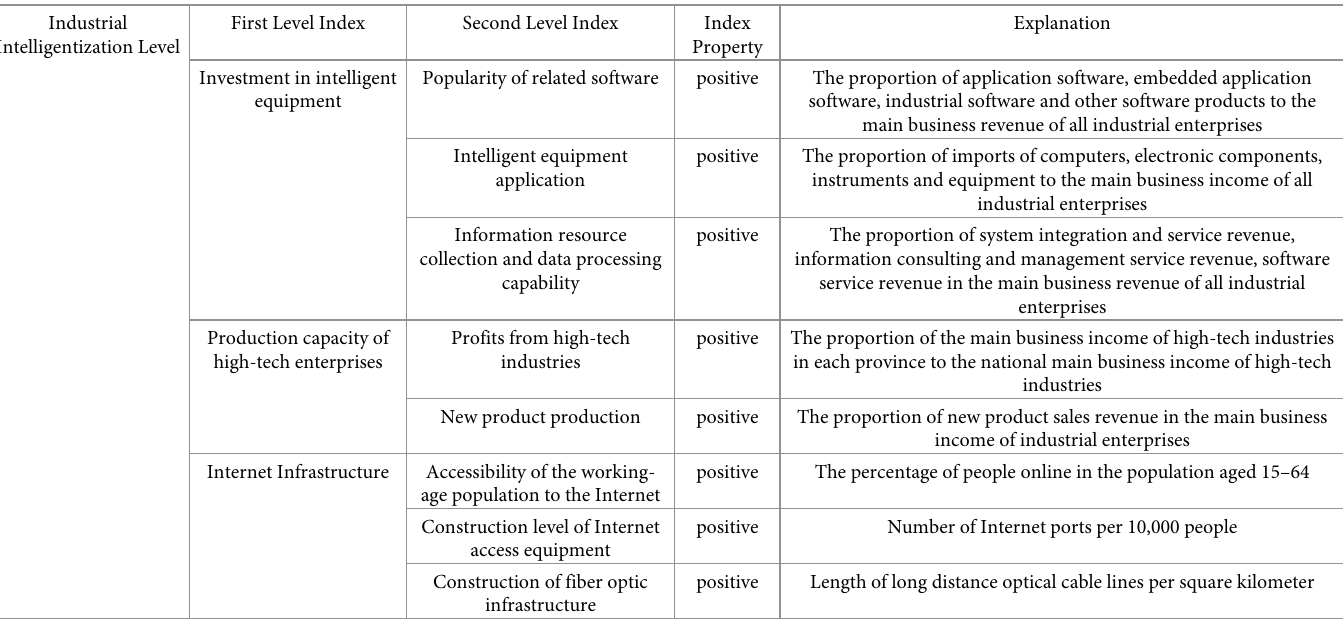
Table 1. Evaluation index system of intelligentization